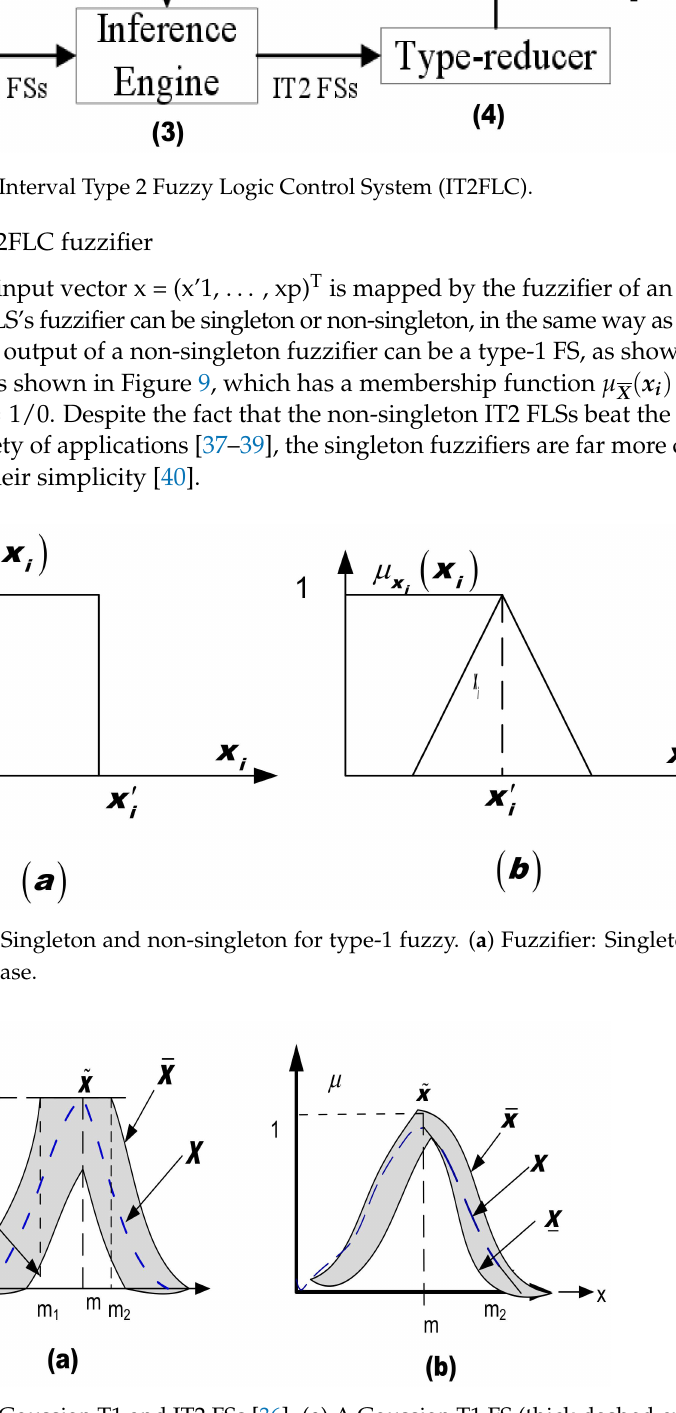
Figure 9. Gaussian T1 and IT2 FSs [36]. ( a ) A Gaussian T1 FS (thick dashed curve) and a Gaussian IT2 FS obtained from blurring the mean of the T1 FS. The FOU can be used to achieve blurring of the membership grade for each element of T2-FLS so that the linguistic value for each MF is not restricted to a crisp value; ( b ) a Gaussian T1 FS (thick dashed curve) and a Gaussian IT2 FS obtained from blurring the standard deviation of the T1 FS not the mean of the